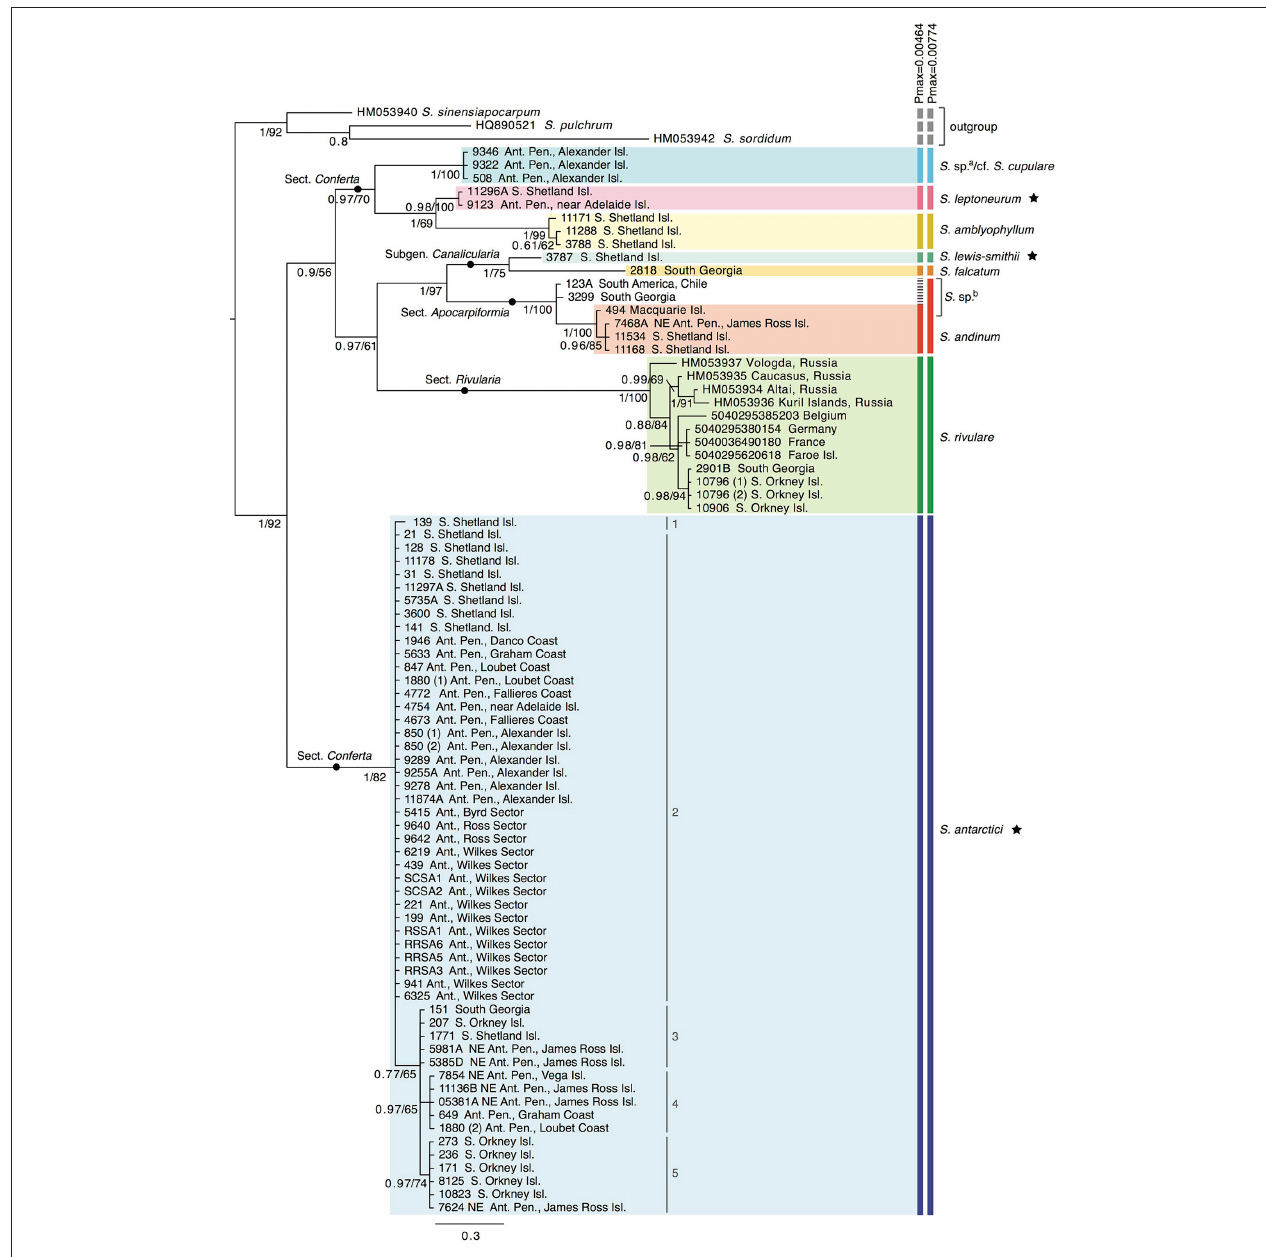
FIGURE 2 | Bayesian phylogeny for Antarctic Schistidium species constructed using the ITS marker. Posterior probabilities and maximum likelihood bootstrap values are shown below each node. The scale bar represents the mean number of nucleotide substitutions per site. Currently recognized endemic species are marked with a star. ABGD species clusters with different P max -values are shown on the right. a = these specimens likely represent S. cupulare (see notes in S1 Table). b = these specimens originally identified as S. apocarpum likely represent a different species (see discussion and notes in S1 Table). Different haplotypes (1–5) within S. antarctici as shown in Figure 3 are provided next to the relevant